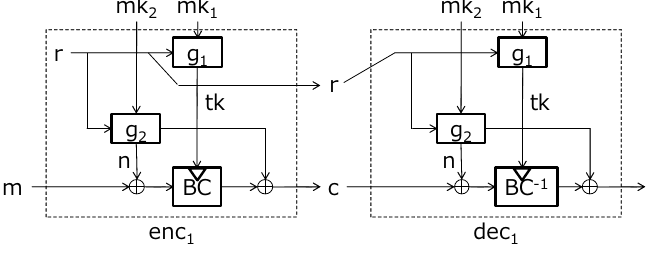
Figure 10. First-order SCA-resistant re-keying scheme.